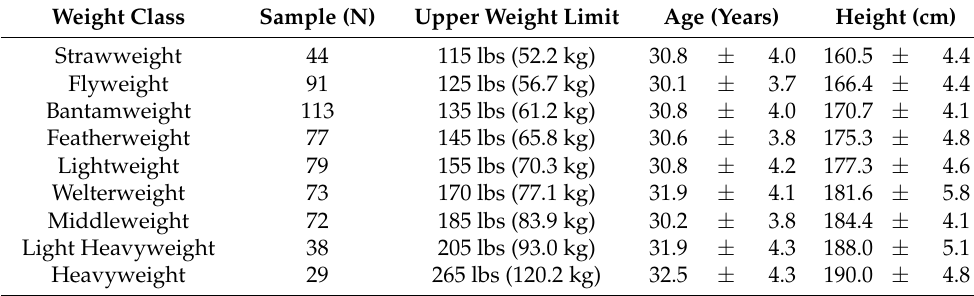
Table 1. Age and height for all athletes by weight class.